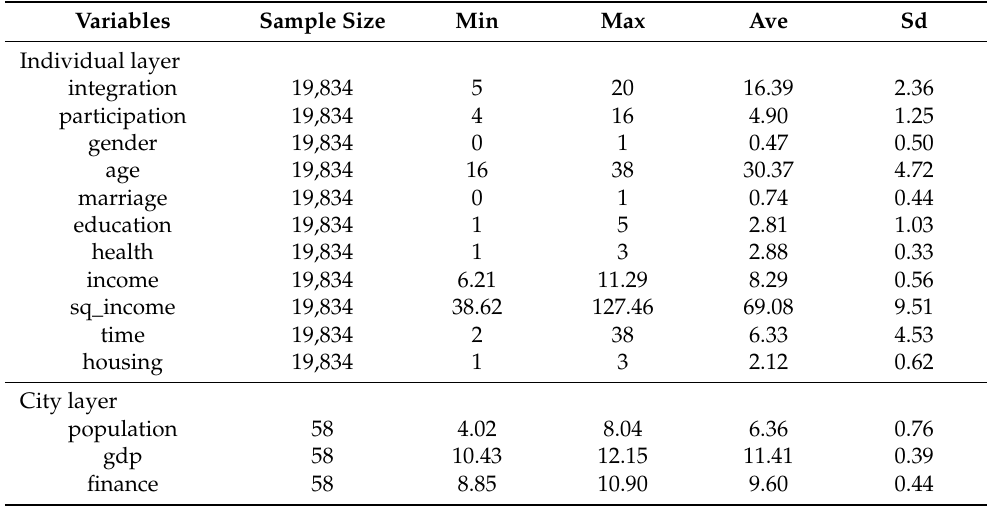
Table 2. Characterization of